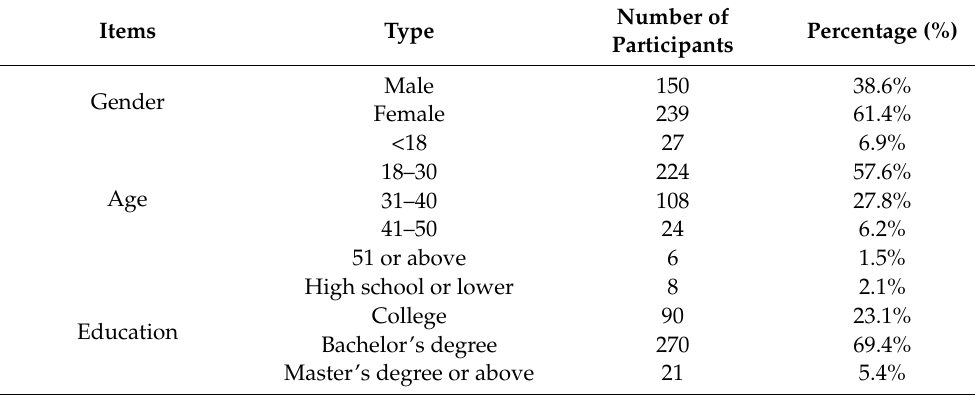
Table 1. Demographic characteristics of the participants ( n =